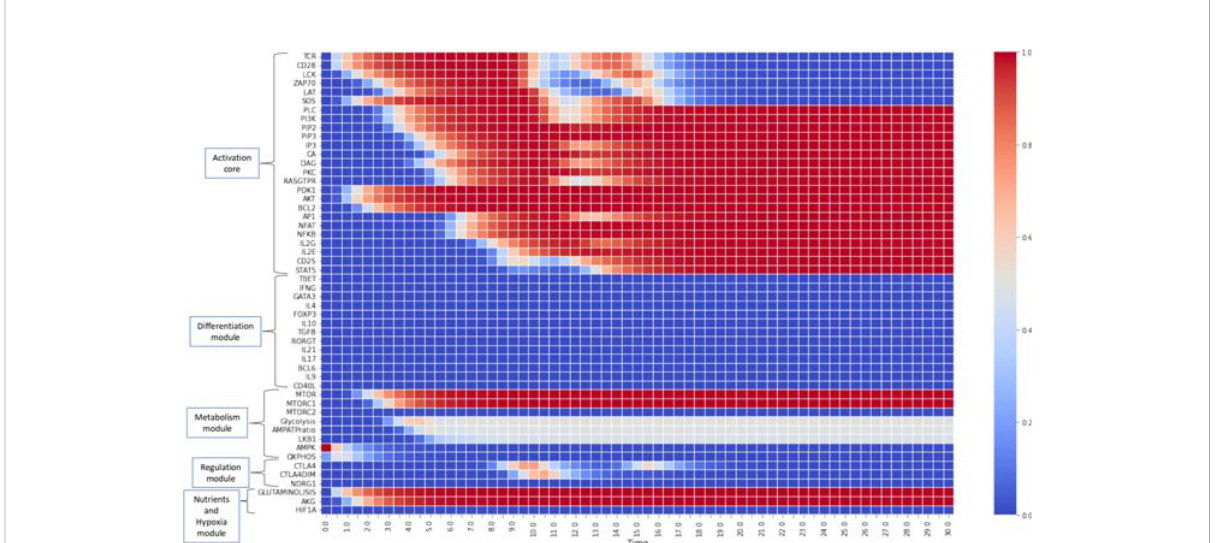
FIGURE 4 Heat map for the continuous dynamics of CD4 + T cell activation events in absence of exogenous cytokines (stimulation time T MHC = T CD 8086 =15 units). Colors indicate the expression level of each node, as shown in the right-hand column. Nodes are grouped into functional modules, whereas environmental input nodes are not shown. The initial network con fi guration is de fi ned by optimal nutrient and normoxic conditions, as well as triggering induced by MHC-antigen and CD80/86. We observe that nodes between LCK and SOS are transiently expressed (according to the activation time) whereas the rest of nodes pertaining to the activation core remain stably activated. Concomitantly, the metabolic module (mTOR and mTORC1) is activated, leading to an initial boost of OXPHOS which decays giving place to a middle-level glycolytic metabolism.